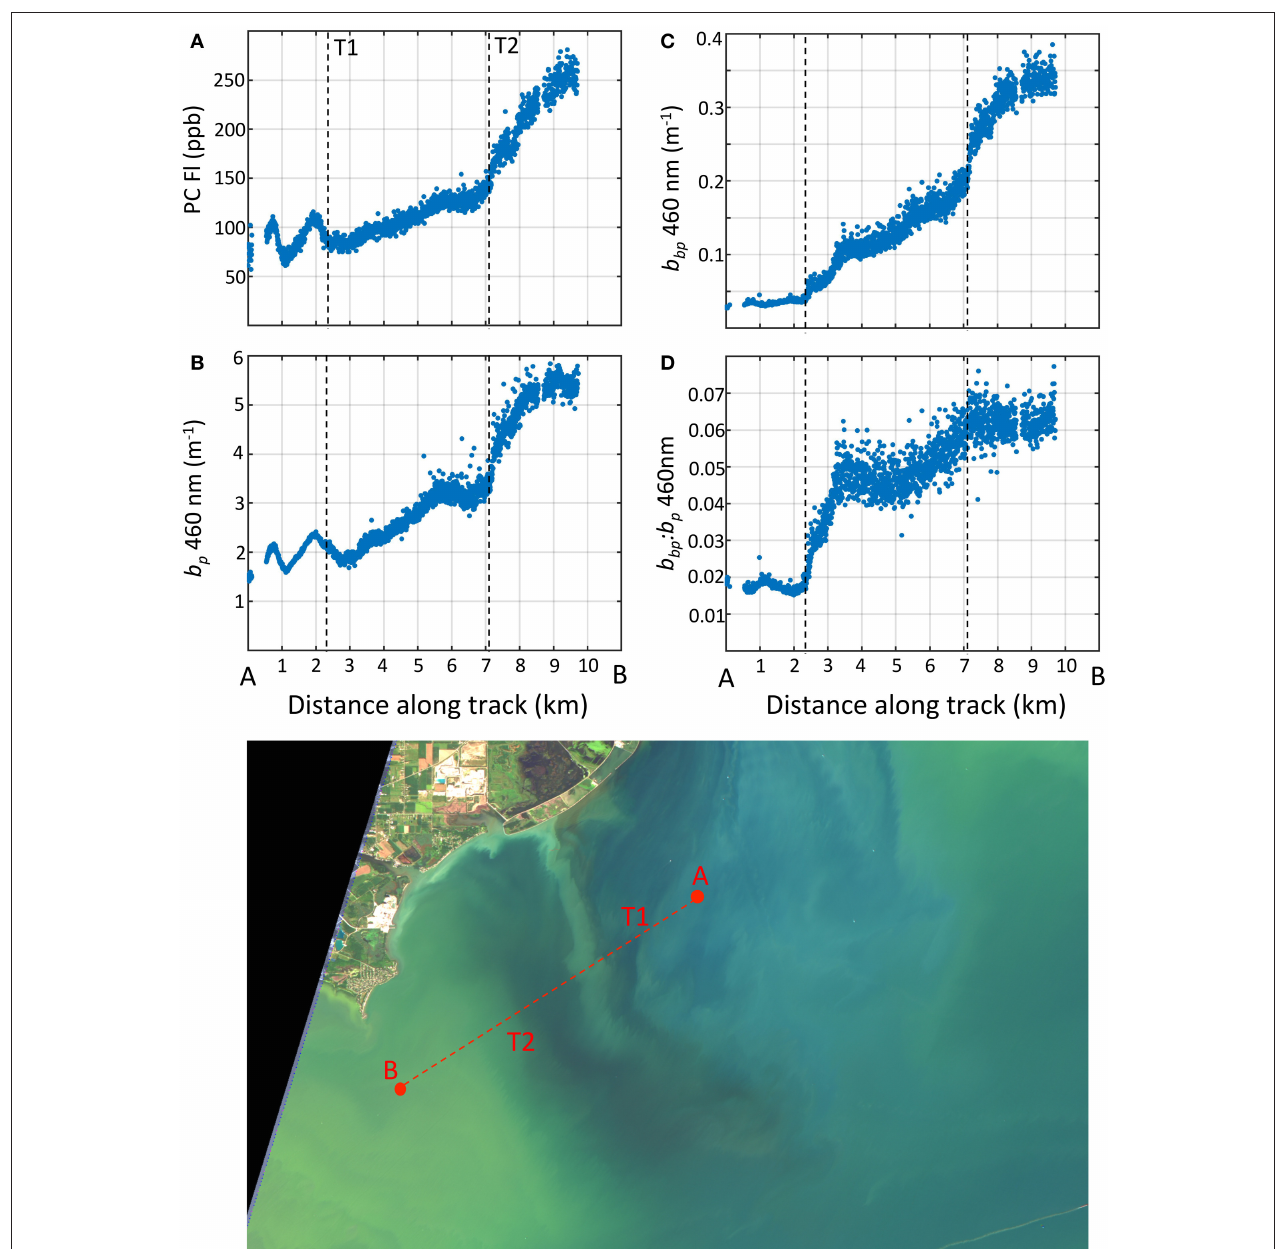
FIGURE 11 | Water properties measured with the towed Dolphin system along a north to south transect crossing the Detroit River plume into the western basin. (A) phycocyanin fluorescence; (B) particle scattering at 460 nm; (C) particle backscattering at 460 nm; (D) backscattering ratio at 460 nm. Bottom image: Raleigh-corrected true color Landsat-8 image captured on Aug. 23, 2013, 1 day after the transect but revealing the general